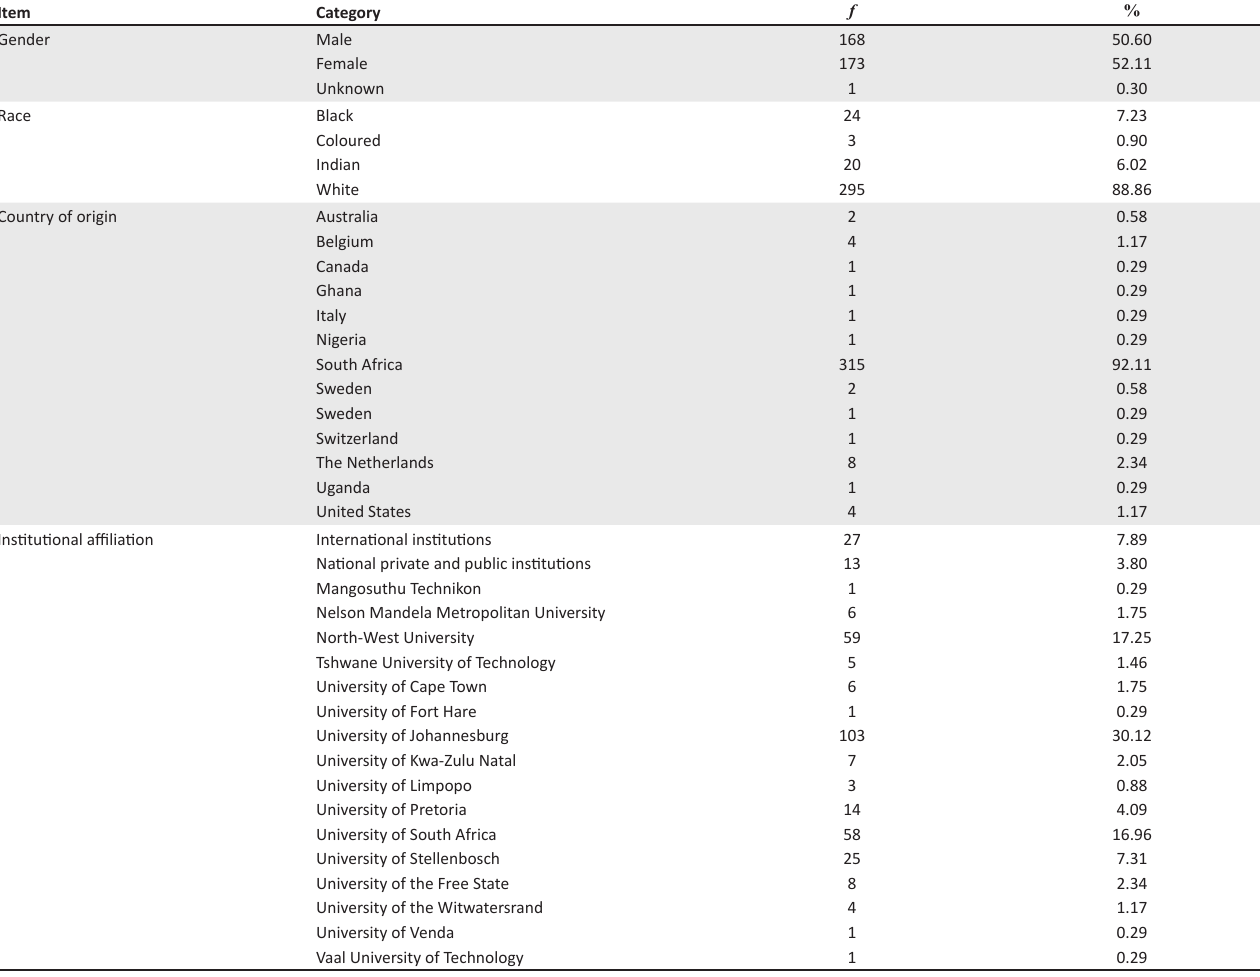
TABLE 2: Characteristics of first authors ( n = 342) Item